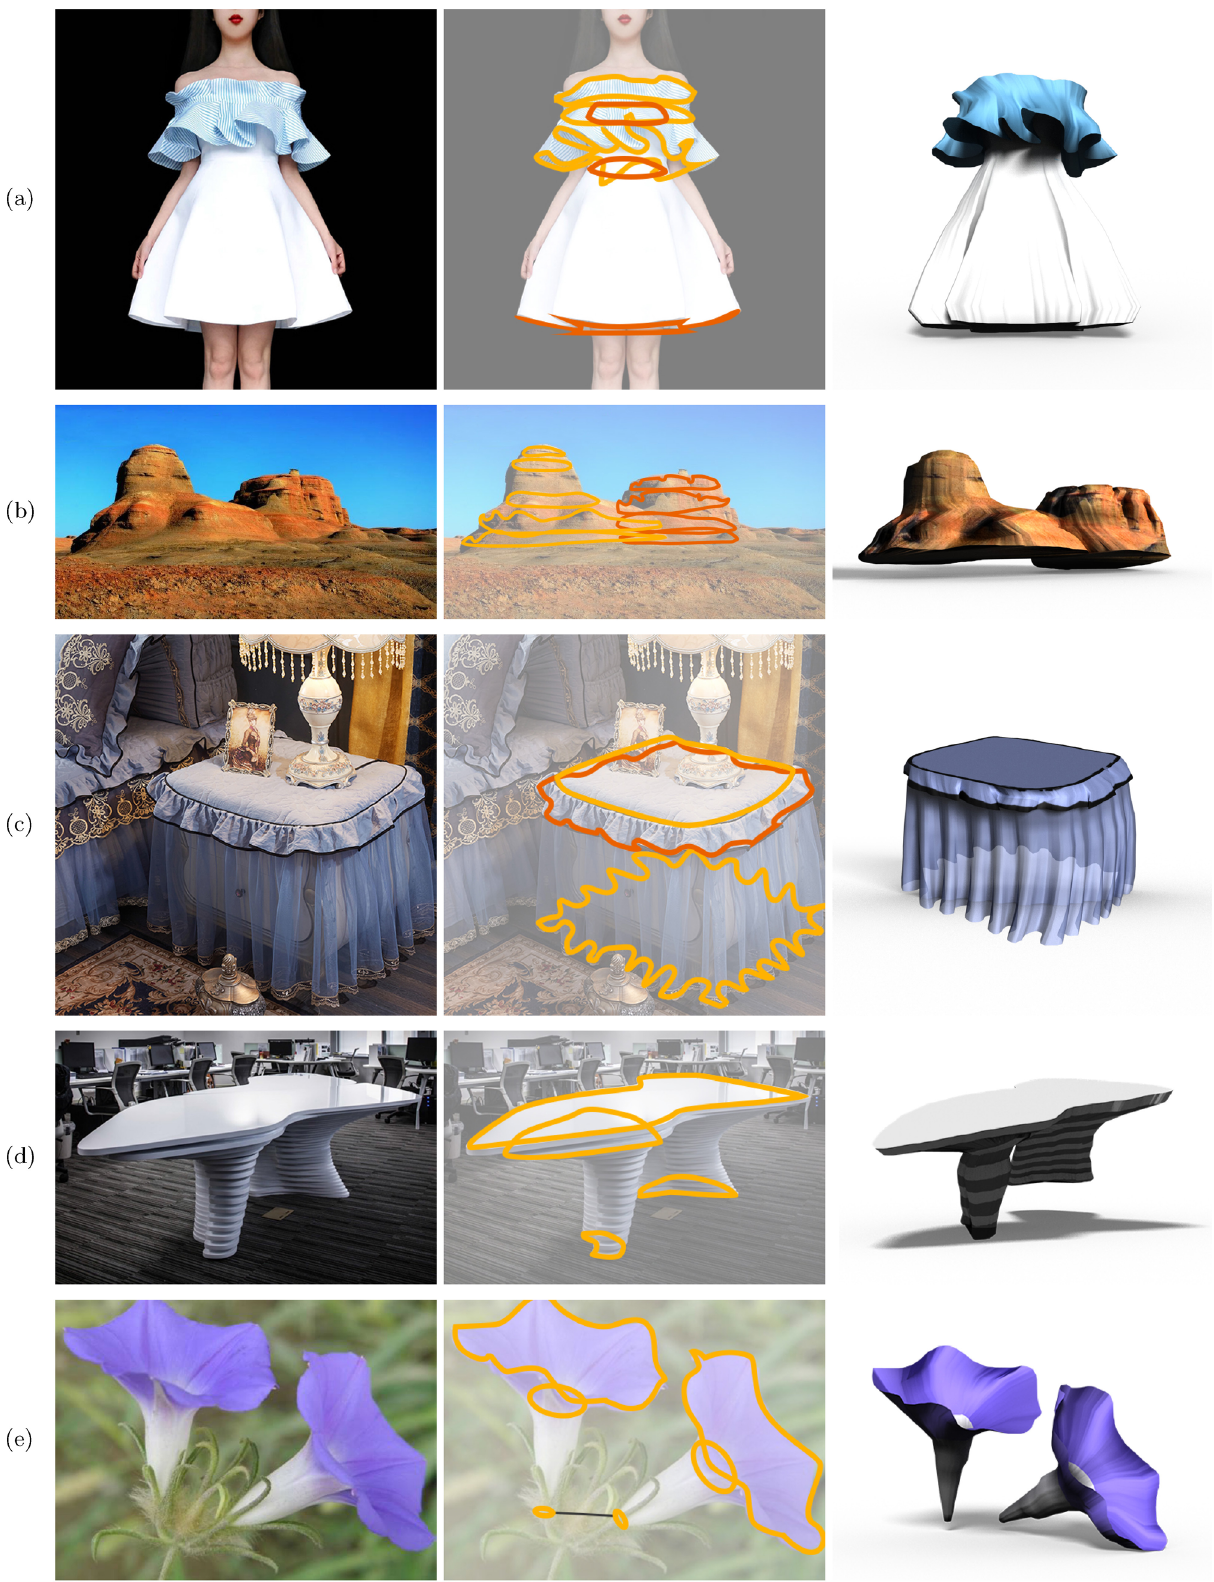
Fig. 8 Modeling lofted shapes with multiple parts. Left: input images. Middle: input curves representing the outlines of cross sections. Right: reconstructed 3D